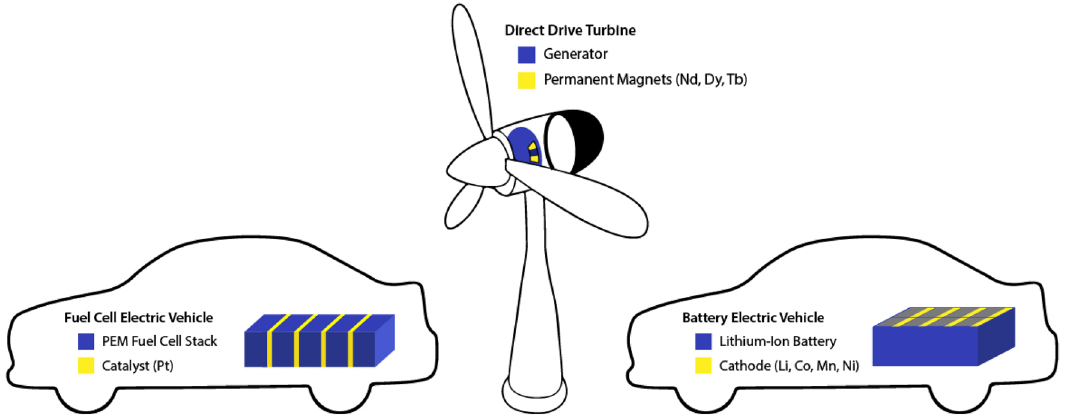
Fig. 1 Schematics of the three case studies considered in this work. From left to right: PEM fuel cell catalysts in fuel cell electric vehicles (FCEVs), NdFeB permanent magnets in generators in direct drive